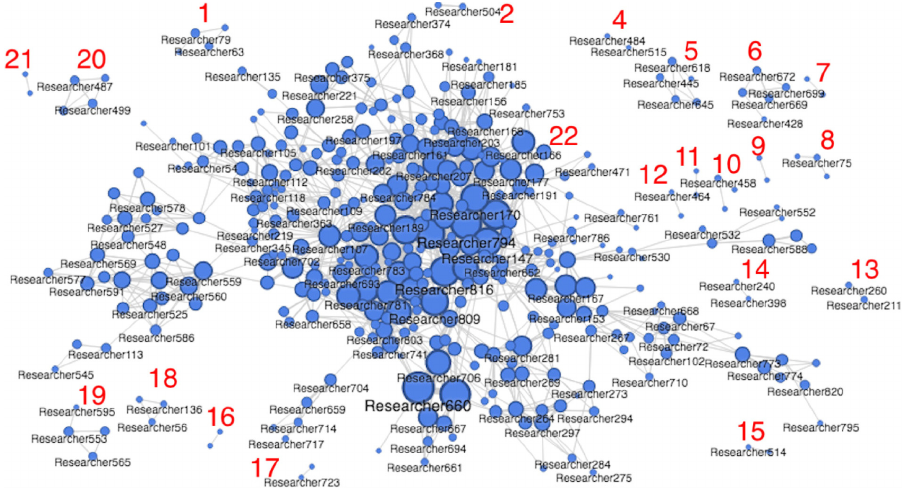
Fig. 2. Graph of representation of the scienti¯c collaboration in UADY.